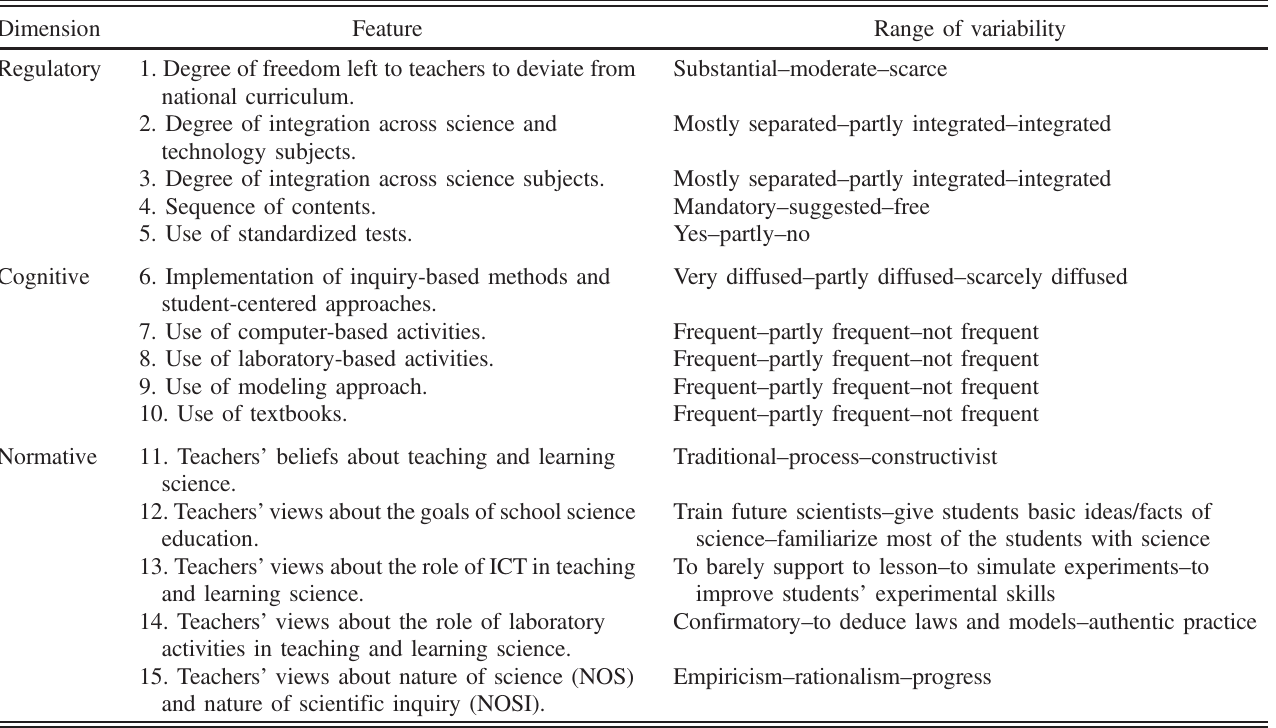
TABLE I. Features used to estimate the institutional distance between Italian and Greek educational contexts. Dimension